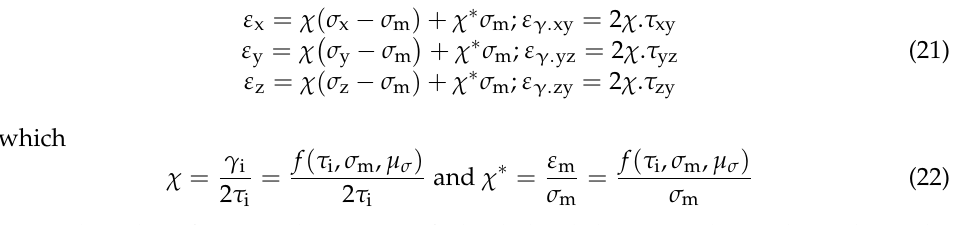
Figure 5. Distribution of ( ) z